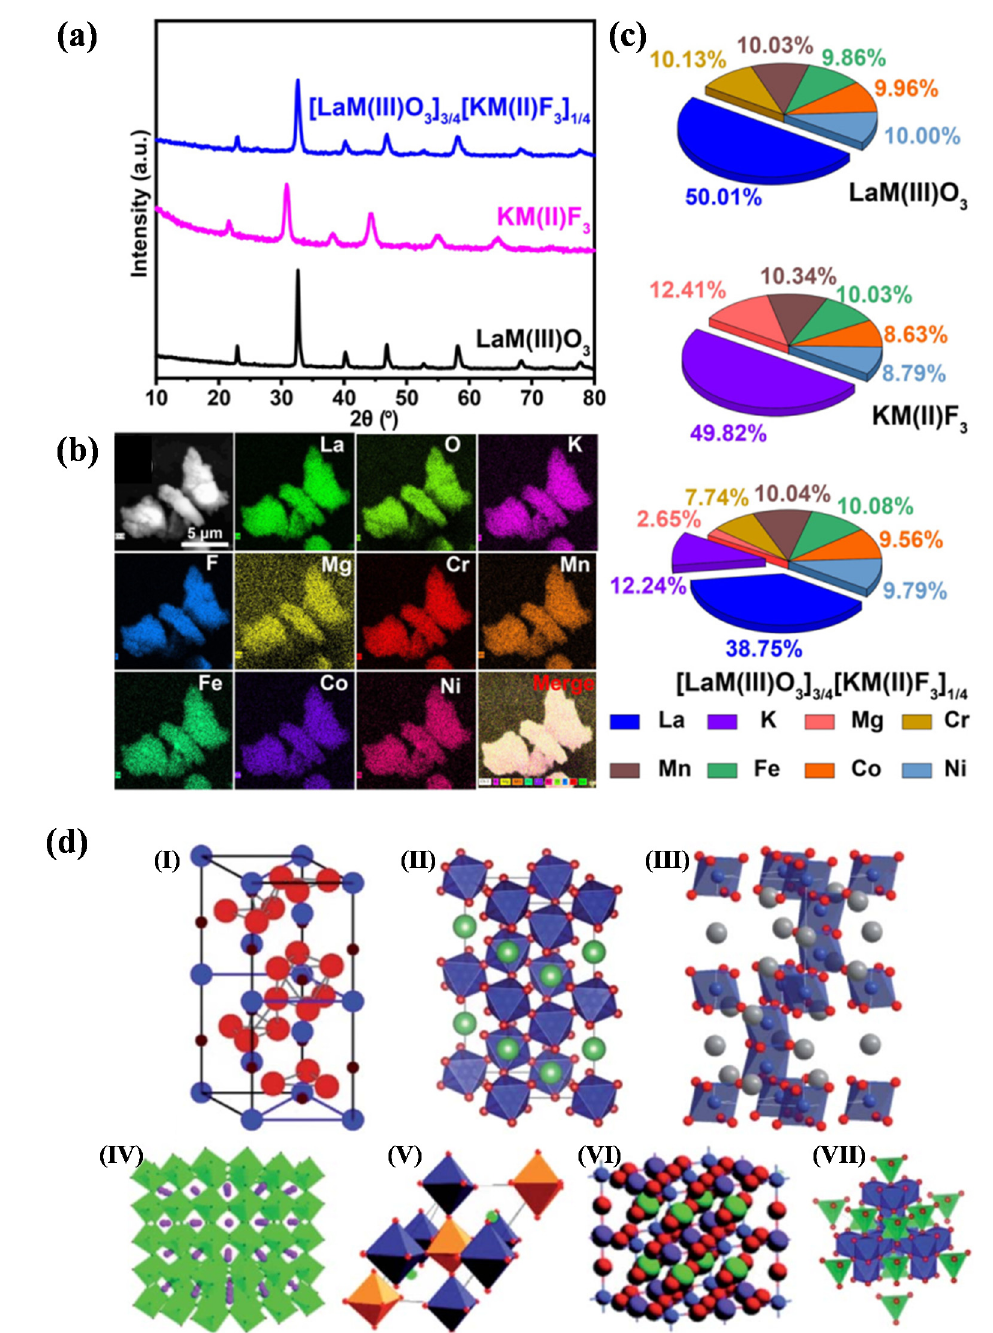
Figure 6. ( a ) XRD diffraction patterns of LaM(III)O 3 , KM(II)F 3 , and [LaM(III)O 3 ] 3/4 [KM(II)F 3 ] 1/4 . ( b ) SEM EDX elemental mappings of La, O, K, F, Mg, Cr, Mn, Fe, Co, and Ni for K(MgMnFeCoNi)F 3 . ( c ) Metal compositions (molar ratio) of LaM(III)O 3 , KM(II)F 3 , and [LaM(III)O 3 ] 3/4 [KM(II)F 3 ] 1/4 calculated from the ICP-AES results. Reproduced with permission from ref. [55], Copyright 2021, Wiley. ( d ) Crystal structures of different A-site perovskite oxides: ( Ⅰ ) structure of the rhombohedral cell in perovskite-type BiFeO 3 ; ( Ⅱ ) schematic illustration of the rhombohedral structured LaCoO 3 perovskite; ( Ⅲ ) hexagonal BaTiO 3 ; ( Ⅳ ) crystal structure of porous CaMnO 3 ; ( Ⅴ ) orthorhombic structure; ( Ⅵ ) unit-cell polyhedral structure of BaBi 0.1 Sc 0.2 Co 1.7 O 6-x at room temperature; ( Ⅶ ) crystal structure with CuO 4 tetrahedra and CoO 6 octahedra. Reproduced with permission from ref. [58], Copyright 2021, Royal Society of Chemistry.